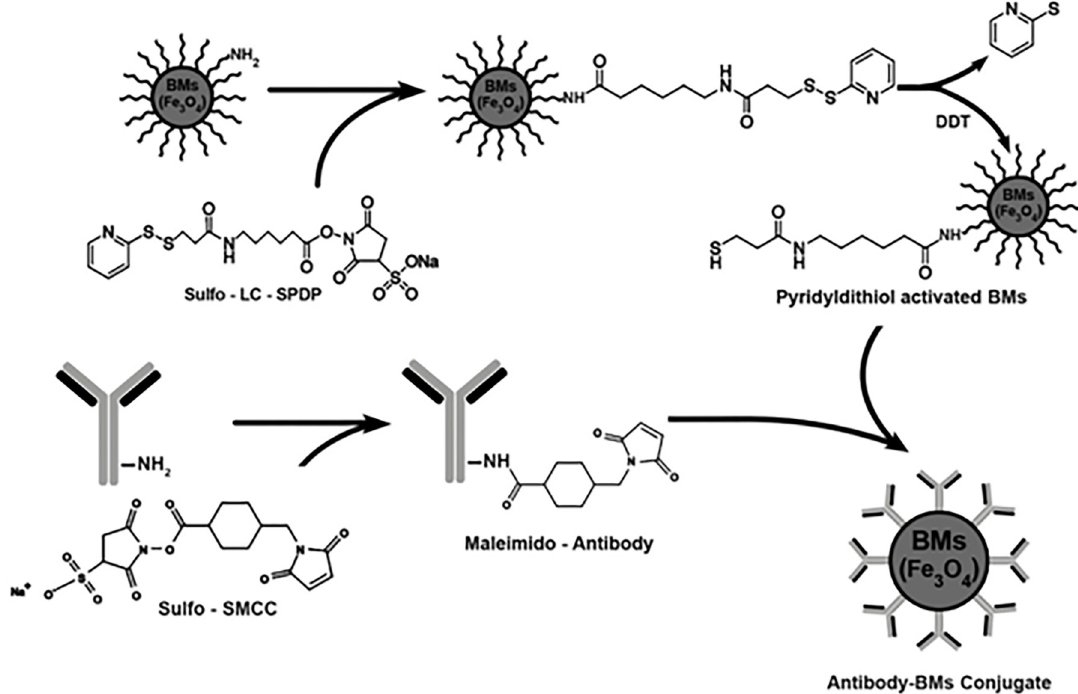
Fig 1. Activation of BMs with Sulfo-LC-SPDP and Mab with Sulfo-SMCC cross-linkers and their